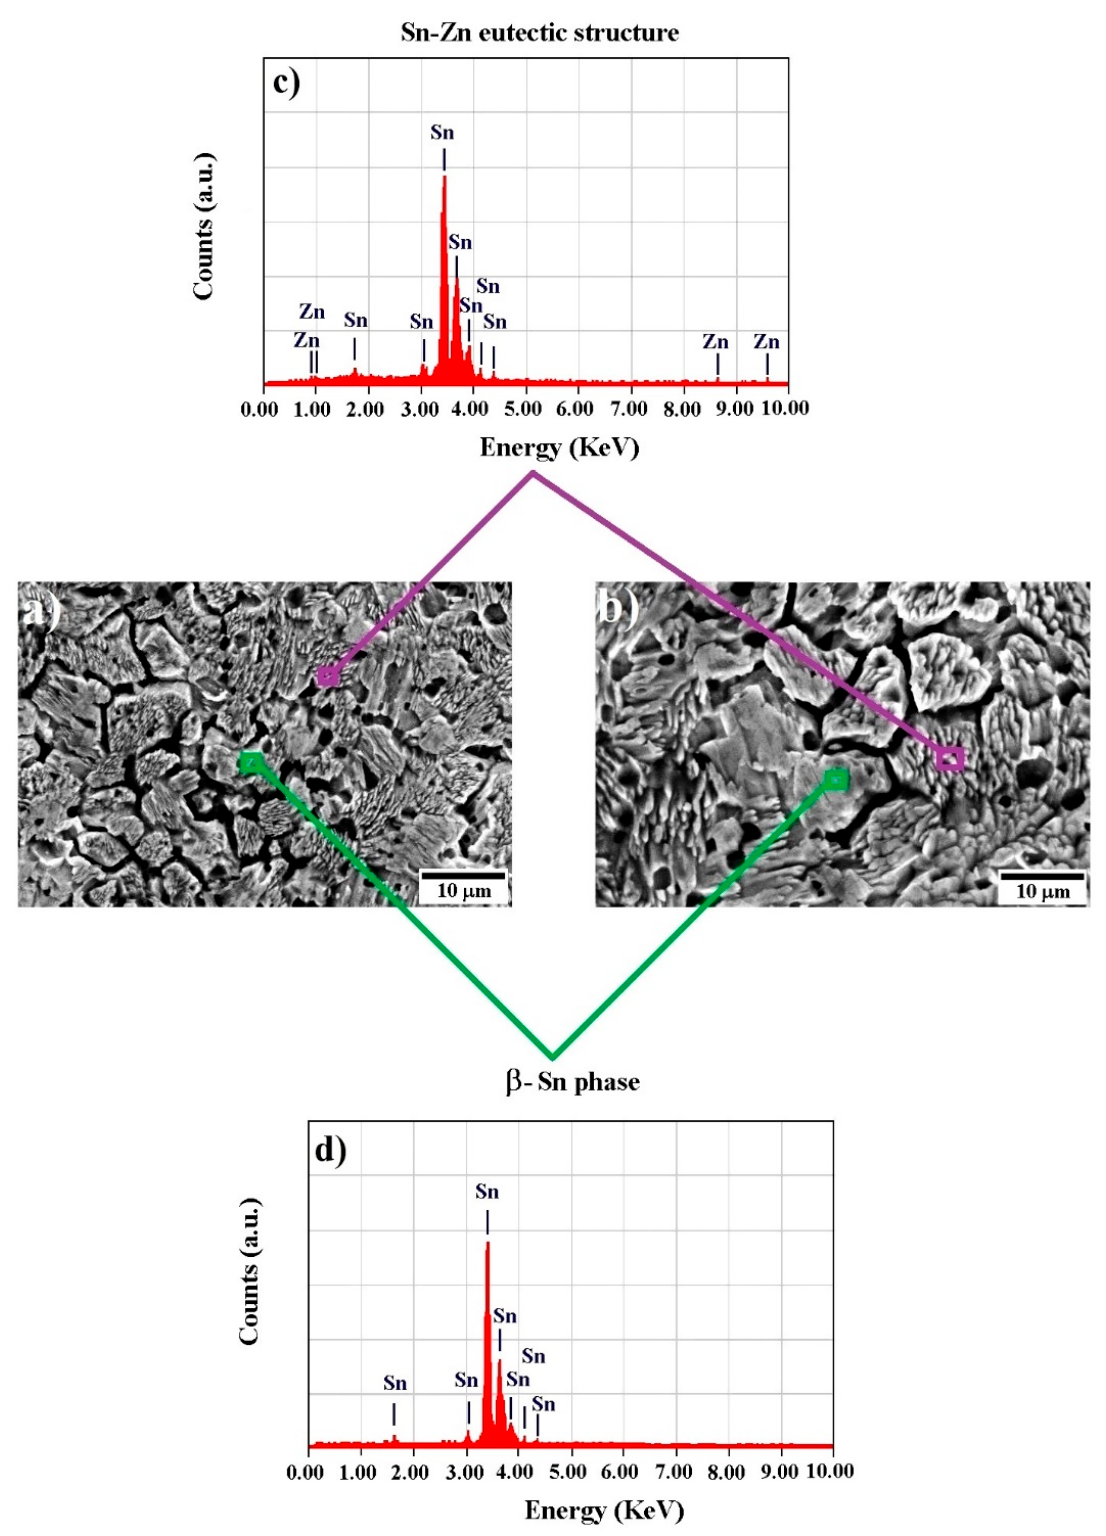
Figure 3. ( a ) SEM image of SZ alloy aged at 323 K, ( b ) SEM image of SZ alloy aged at 398 K, ( c ) EDS spectrum of Sn-Zn eutectic structure, and ( d ) EDS spectrum of β -Sn phase.